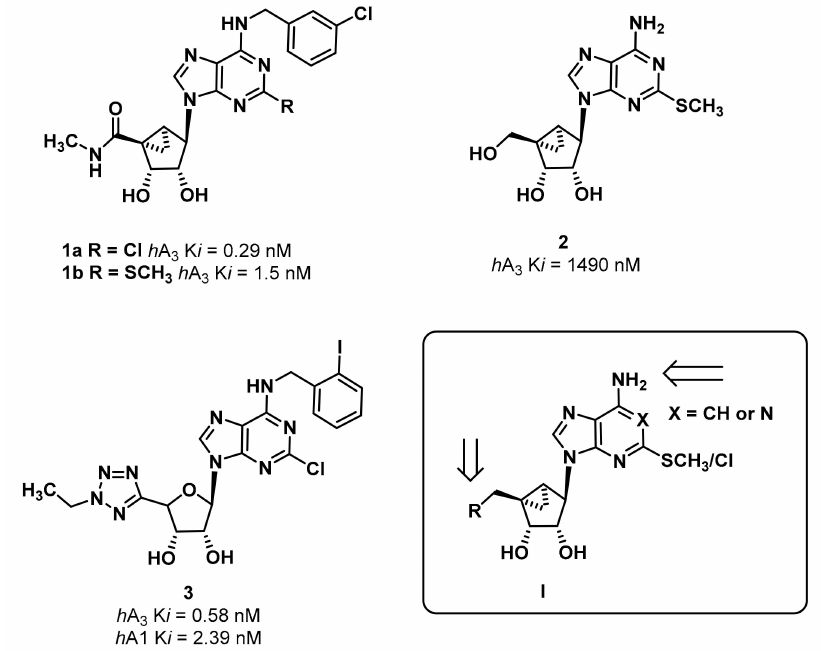
Figure 1. (N)-methanocarba-based A 3 receptor antagonists 1a,b , 2 , the tetrazole derivative 3 and general structure I